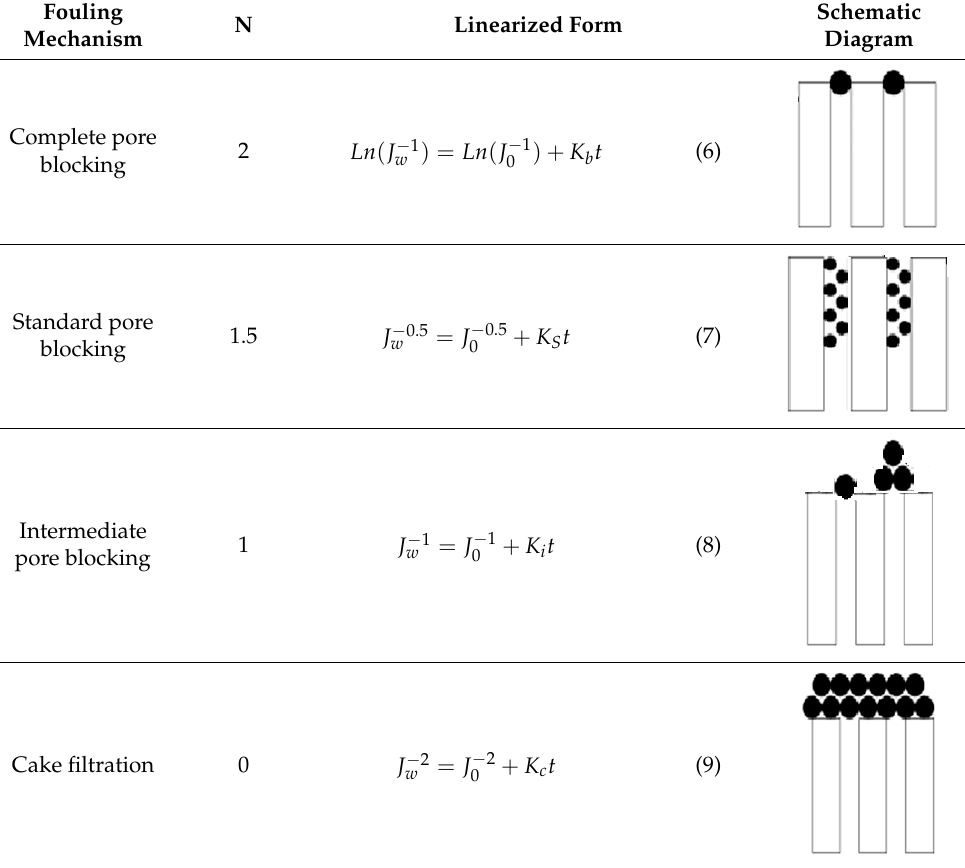
Table 4. Fouling mechanisms based on the Hermia model. Fouling Mechanism N